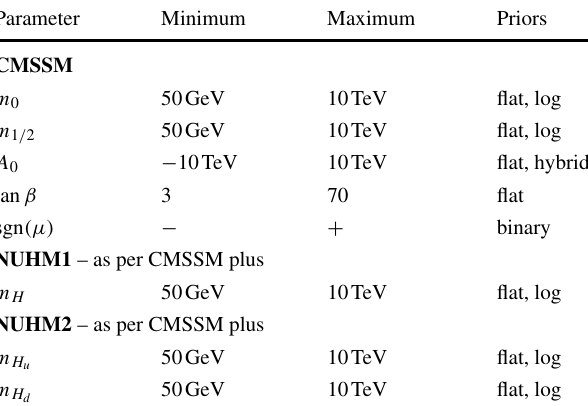
Table1 CMSSM,NUHM1andNUHM2parameters,rangesandpriors adopted in the different scans contributing to the final results of this paper. The “hybrid” prior for A 0 is flat where | A 0 | < 100GeV, and logarithmic elsewhere. The “binary” prior for sgn (μ) indicates that we repeated every scan for each sign. In addition to the listed priors, we also performed supplementary scans restricted to models with